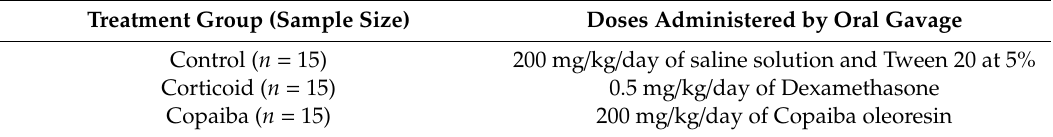
Table 1. Experimental groups according to the doses of treatment or vehicle received. Treatment Group (Sample